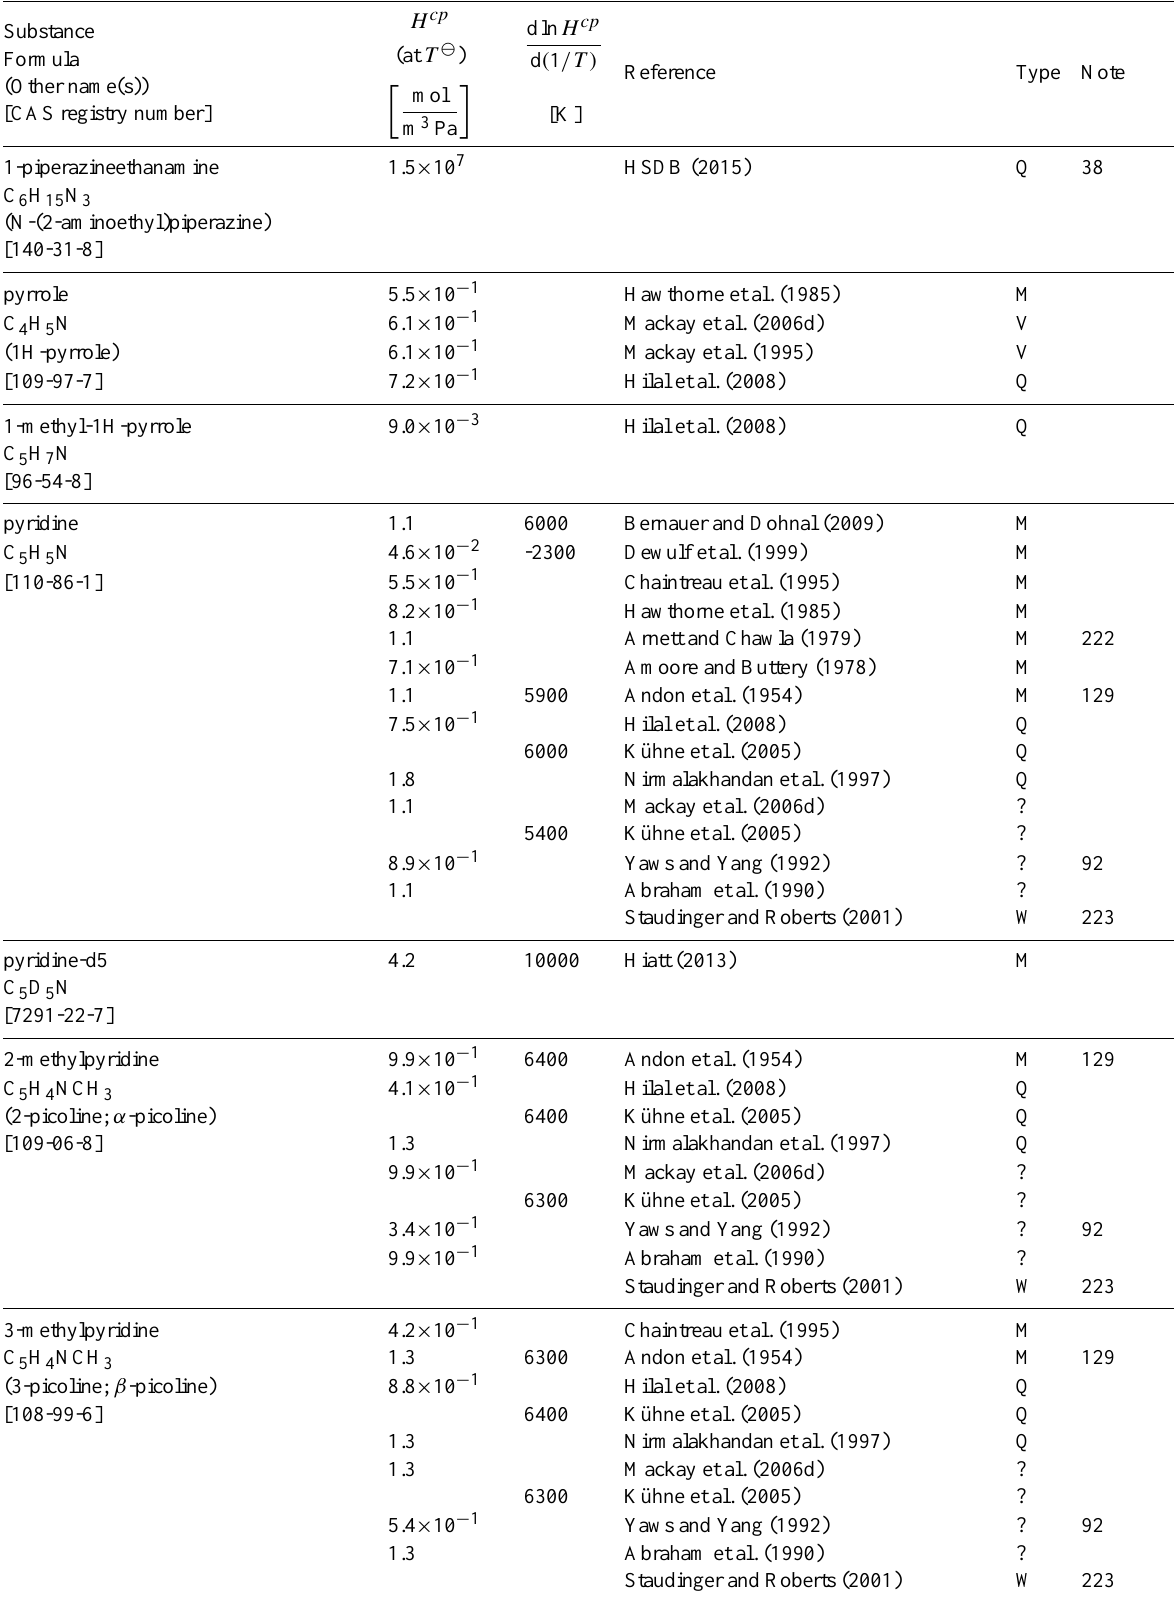
Table 6: Henry’s law constants for water as solvent